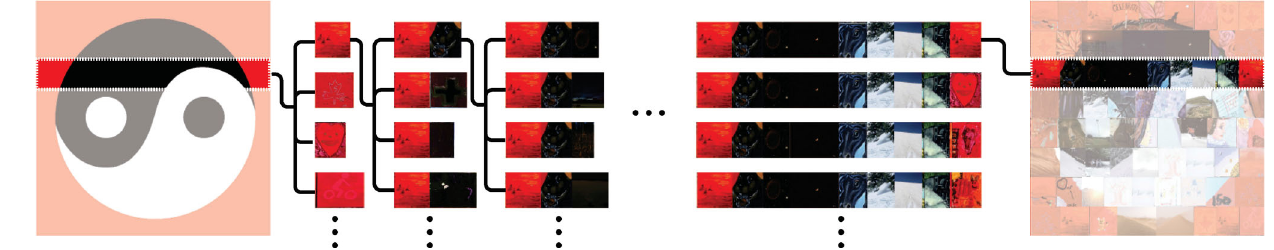
Fig. 4 For each row of the target image, we obtain the optimal tile set using dynamic